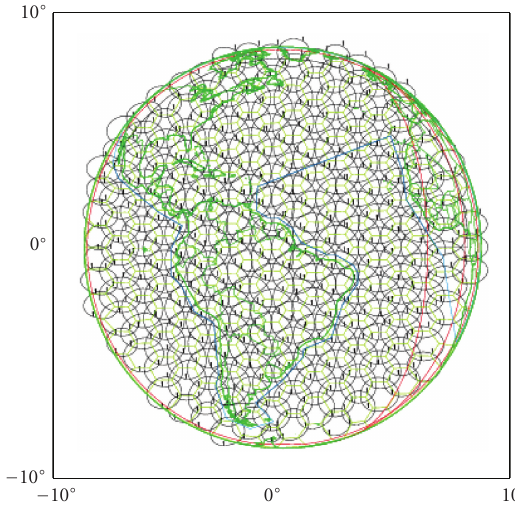
Figure 2: Example fixed